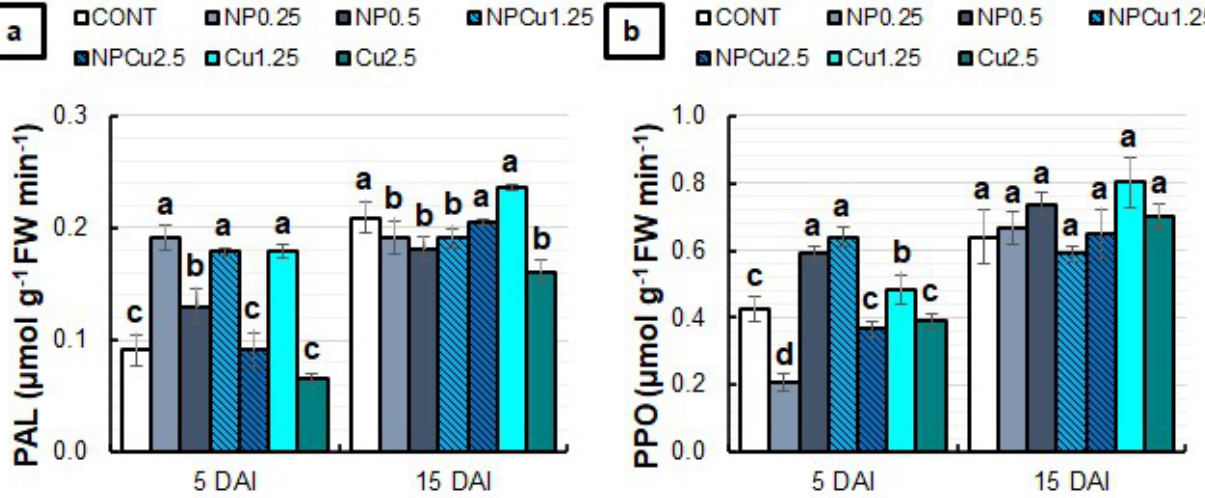
Figure 9. The activity of phenylalanine ammonia-lyase (PAL) ( a ) and polyphenol oxidase (PPO) ( b ) enzymes of leaf discs of Coffea arabica cv. IPR 100 at 5 and 15 days after infection (DAI) with H. vastatrix . Before infection, the discs were treated with distilled water as a control (CONT), chitosan nanoparticles without Cu 2+ ions (NP), chitosan nanoparticles containing Cu 2+ ions (NPCu), and free Cu 2+ ions (Cu). The formulations were diluted in distilled water, obtaining the corresponding concentrations of chitosan (CS) in NP and NPCu treatments (0.25; 0.5 g L − 1 ) and of Cu 2+ ions (1.25; 2.5 mmol L − 1 ) in NPCu and Cu treatments. Results are expressed as mean ( n = 4) ± standard error. Equal letters in the columns indicate that there was no significant difference in the Scott–Knott test ( p < 0.05) at the same time point.